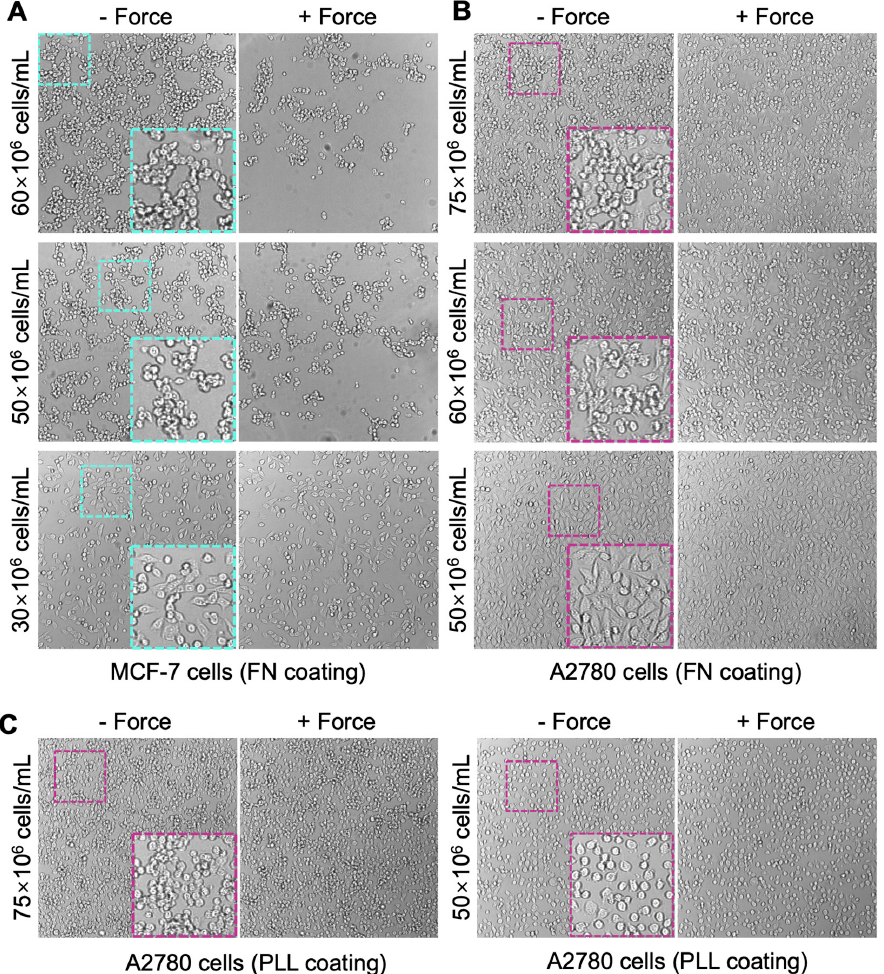
Figure 3. Monolayer cell seeding. MCF-7 cells ( A ) and A2780 cells ( B ) were seeded in the flow chamber at multiple density from 30 × 10 6 to 75 × 10 6 cells/mL to make the monolayer. The glass surface of the flow chamber was pre-coated with FN to enhance cell attachment. Representative images of the monolayer (at each seeding condition) after 2 h incubation at 37 °C (i.e., − Force) and then validation using acoustic force (i.e., +Force) were shown. After validation, weakly adhered cells were lifted from the coated surface and washed out using complete medium. ( C ) PLL coating was also tested to make A2780 cell monolayer at 75 × 10 6 ( left ) or 50 × 10 6 cells/mL ( right ) seeding density. Representative images of the monolayer after 2 h incubation with (+Force) or without ( − Force) validation were shown. Insert: the zoom-in images showing the confluency of cell monolayer and the cell morphology.